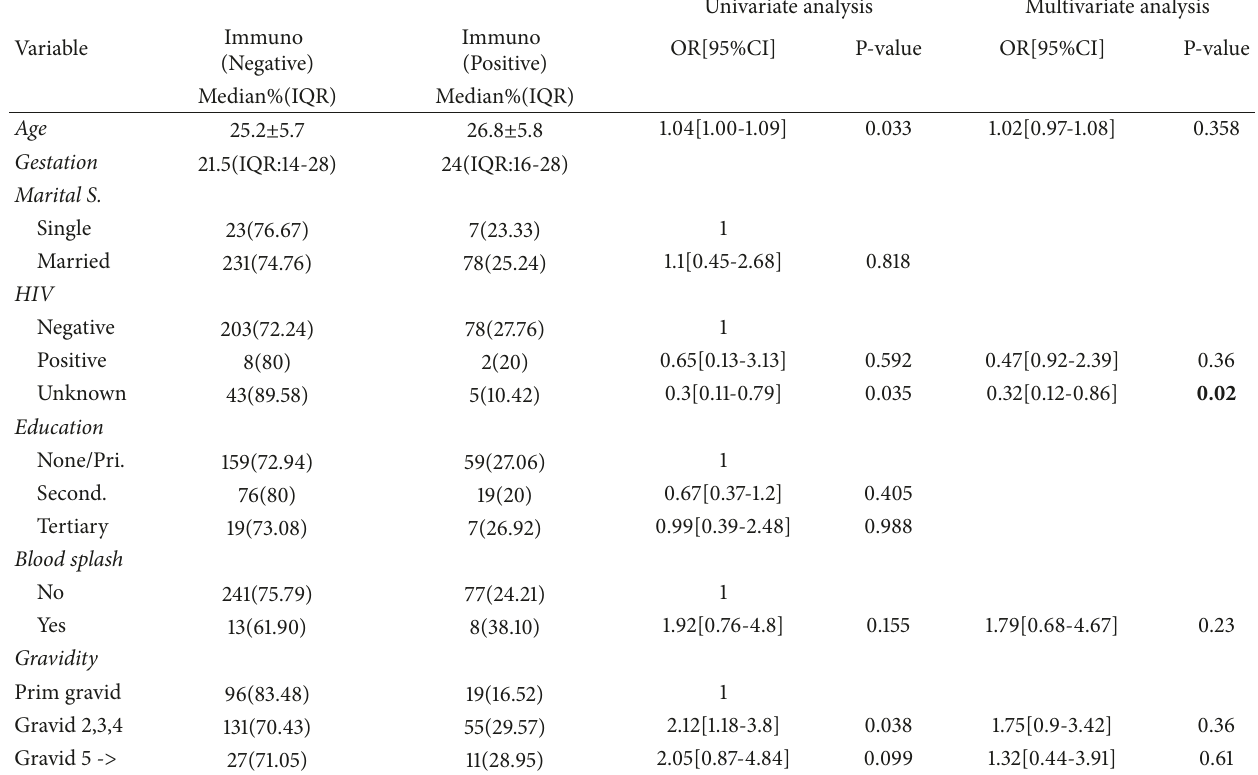
Table 2: Factors associated with anti-HBs seropositivity among 339 pregnant women attending Makongoro antenatal